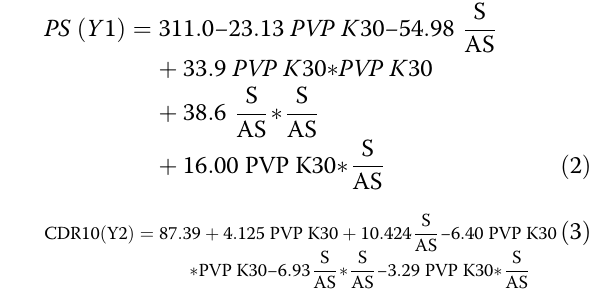
particle size ( Y ) and CDR10 ( Y ) were the trans- 1 2 formed in actual value as below. The significant F ra- tio and R 2 in Table 4 suggested that there was a good linearity between the predicted and the observed values as a result of this %relative errors were also less as reported in Table 5 [17].